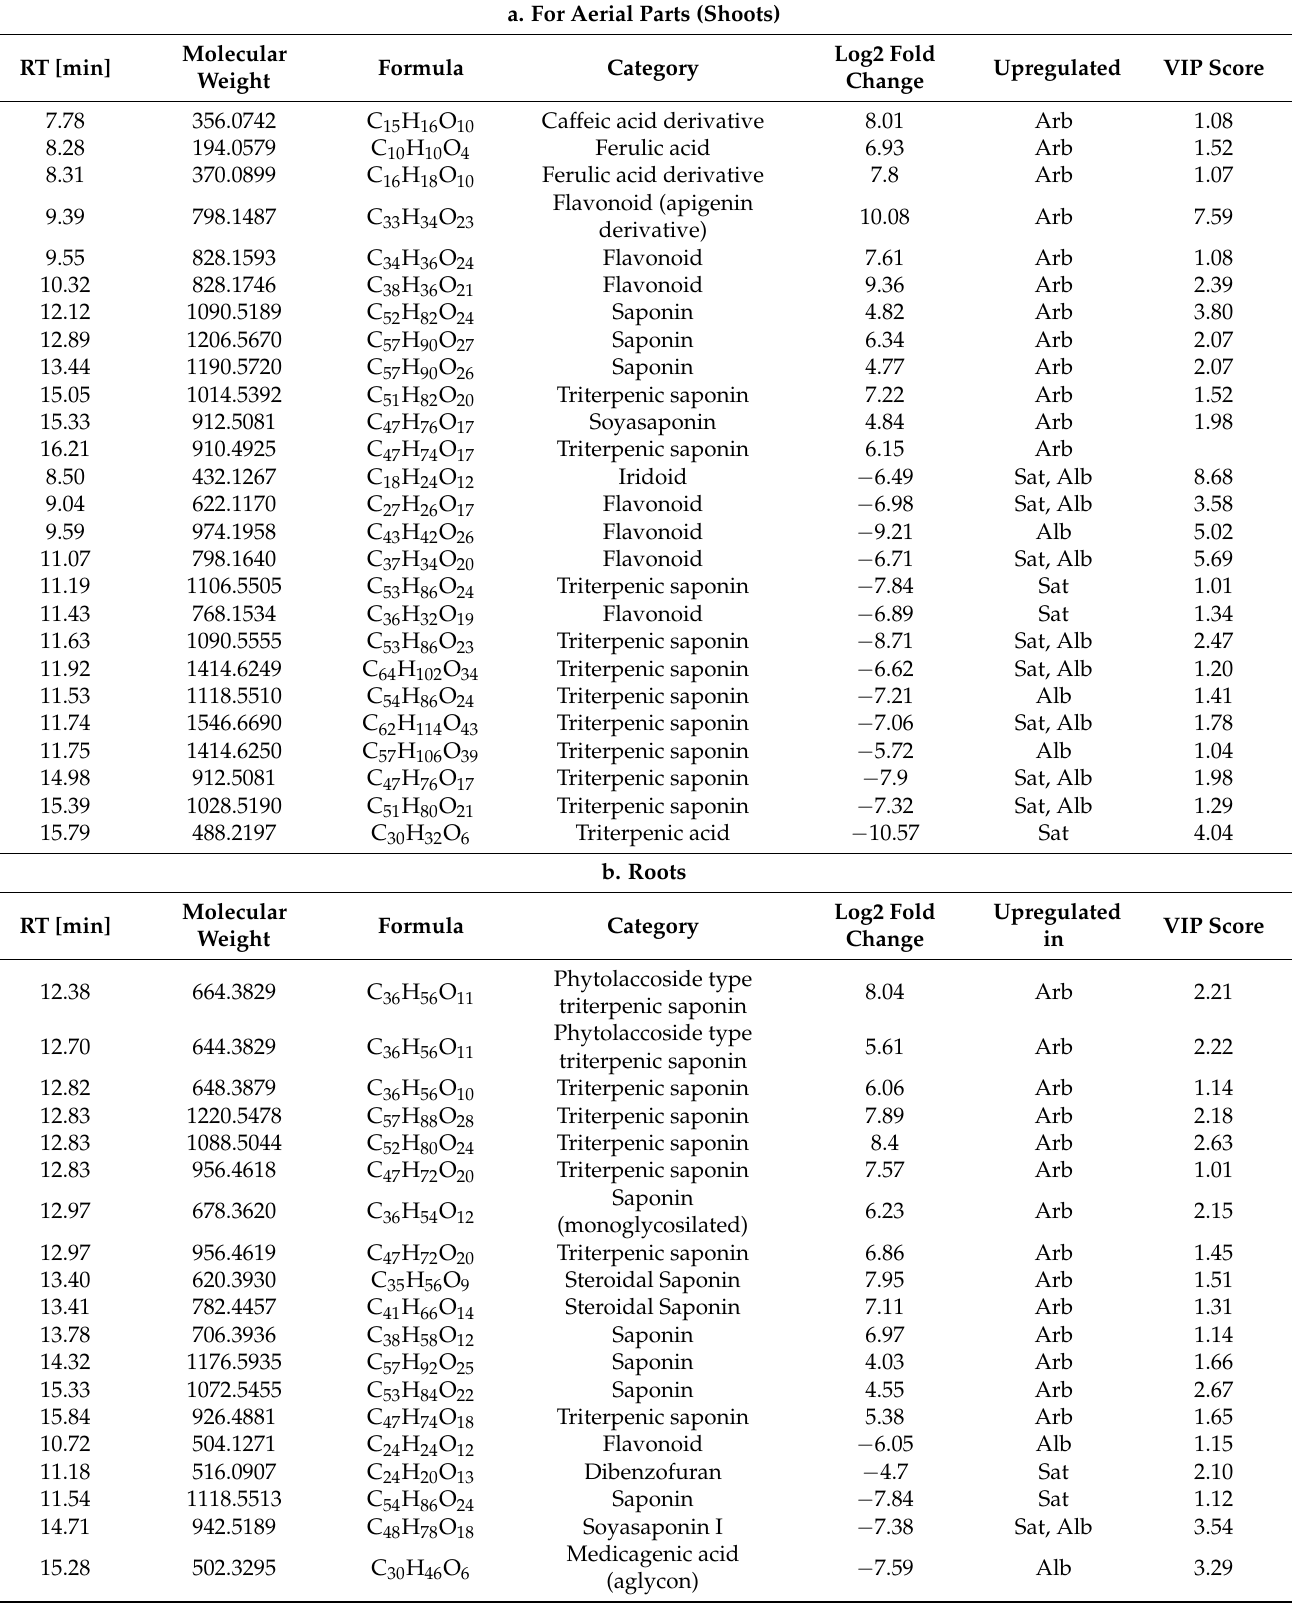
Table 2. VIP features (secondary metabolites) with their retention times (RT), molecular weight, molecular formu- las, their tentative identification and their statistical measurements that characterize each species subjected to gradual salinity